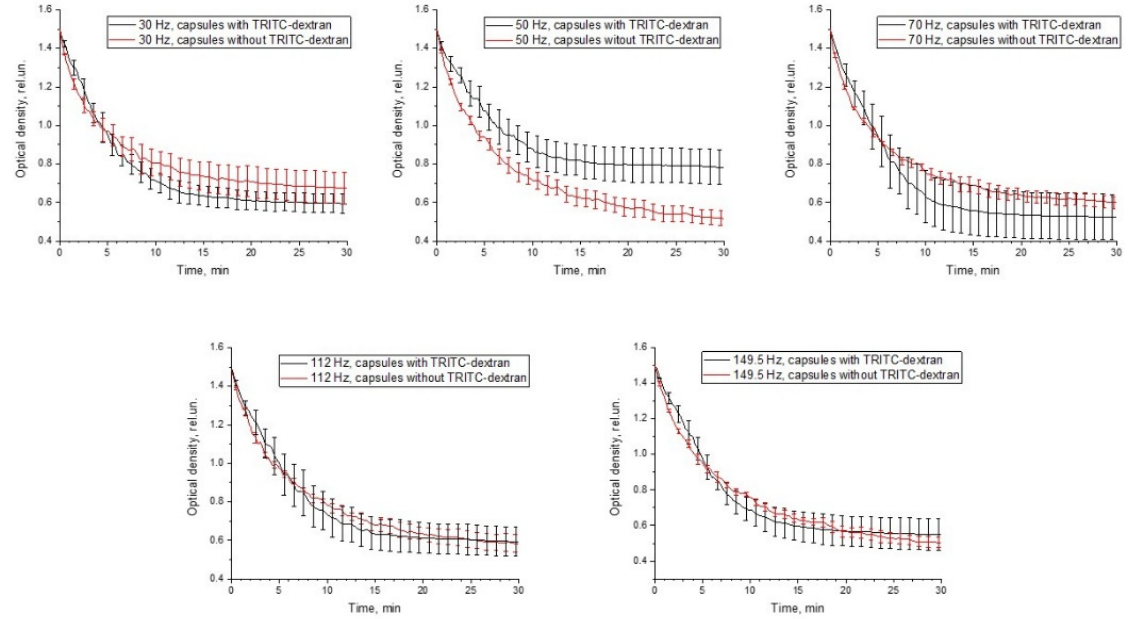
Figure A6. Optical density curves for suspension of capsules loaded with TRITC-dextran and for control samples (without TRITC-dextran) under exposure with 100 mT alternating magnetic field with frequencies 30, 50, 70, 120, 150 Hz. Table A1. Values of adjuster r-squared parameter for fit of used samples. . Capsules without